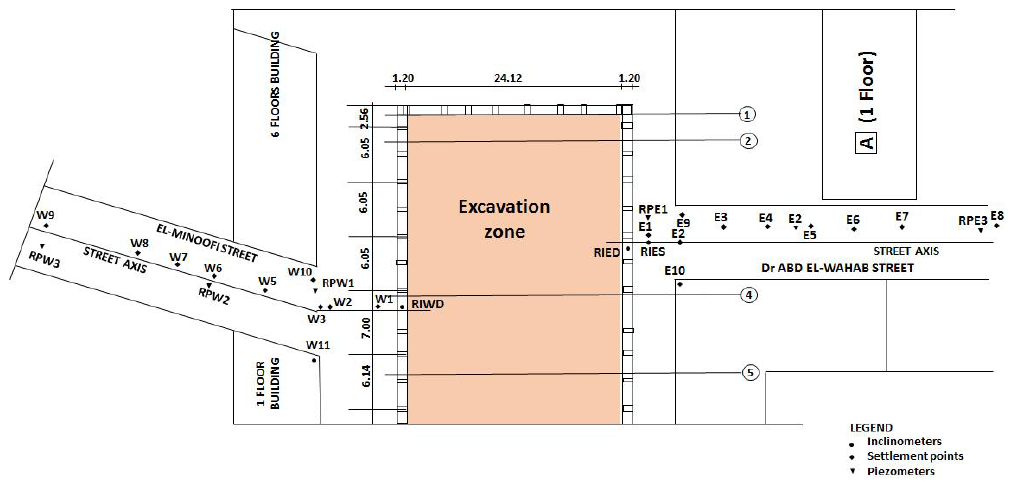
Figure 2. Instrumentation system layout [30].